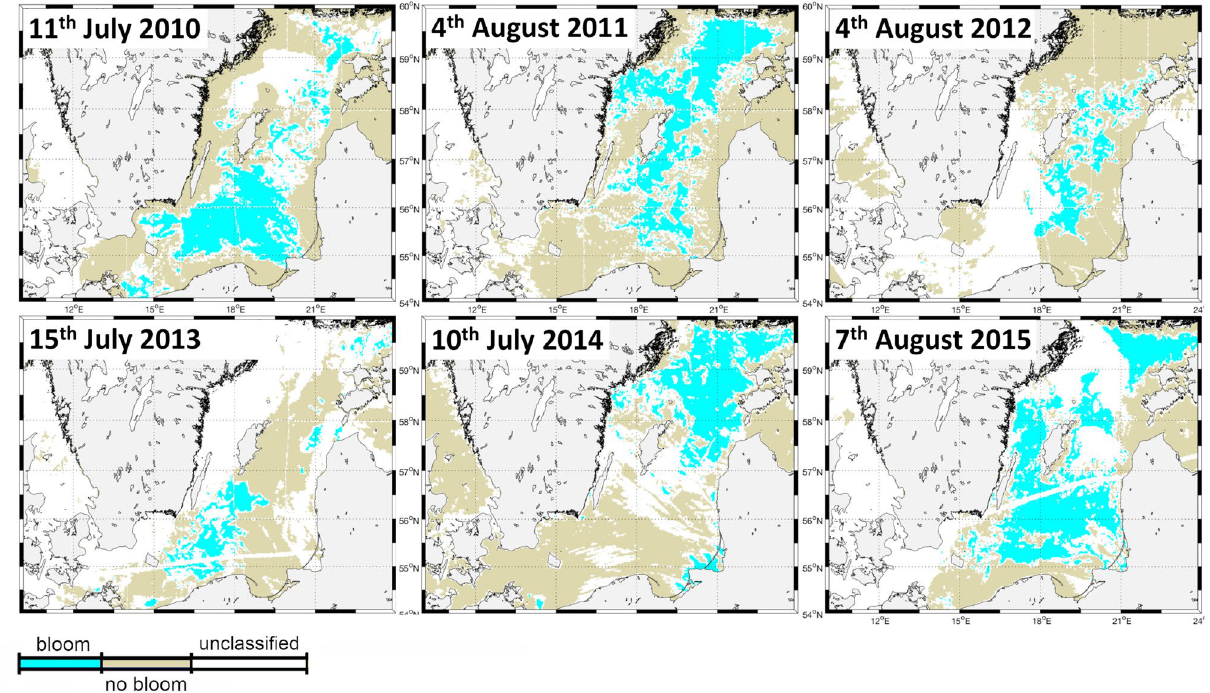
Figure 2. Major cyanobacteria blooms during 2010-2016 for which origins were retraced 60 days backwards in time. Cyan marks grid points where a boom was detected while the beige color marks grid points with no bloom occurrence. White refers to pixels which could not be attributed (due to clouds or uncertain/sub-surface blooms). This figure was created with Matlab (https:// www. mathw orks. com/ produ cts/ matlab.